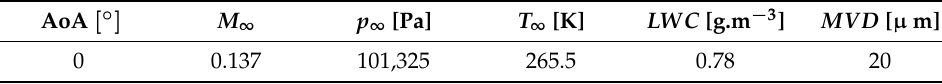
Table 7. Aerodynamic and icing conditions for deicing Case 1.